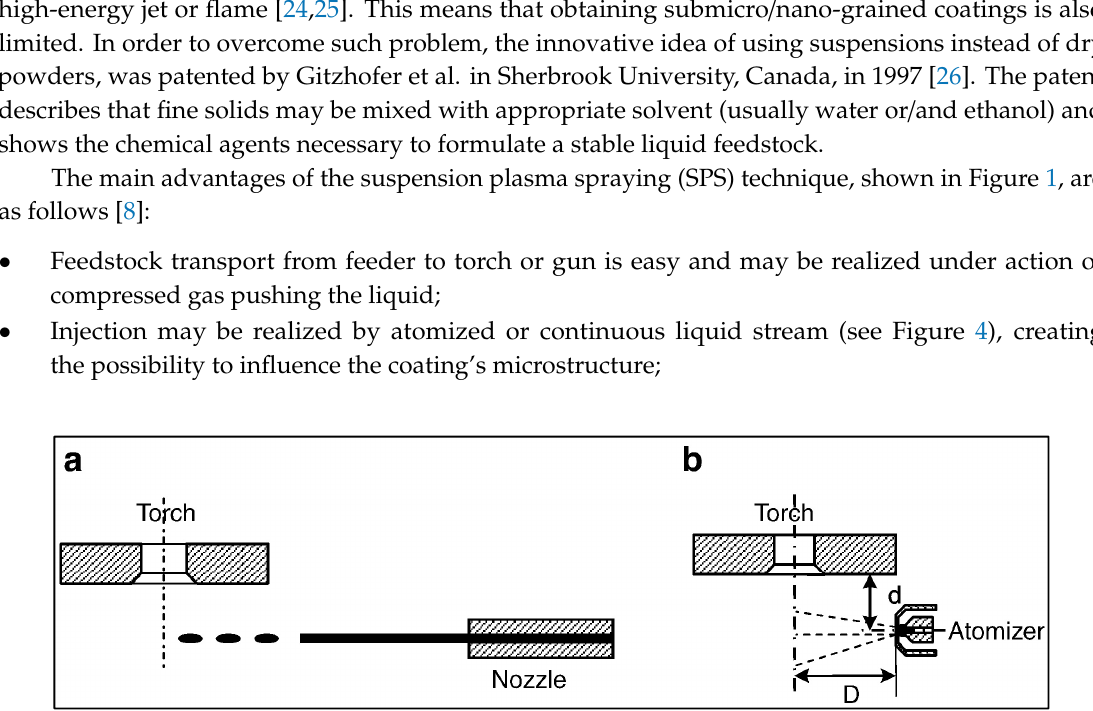
Figure 4. Injection of liquid using continuous stream, ( a ) and atomized stream, ( b ), after [8]. Reproduced with permission from [Surface and Coatings Technology], Elsevier, 2008.